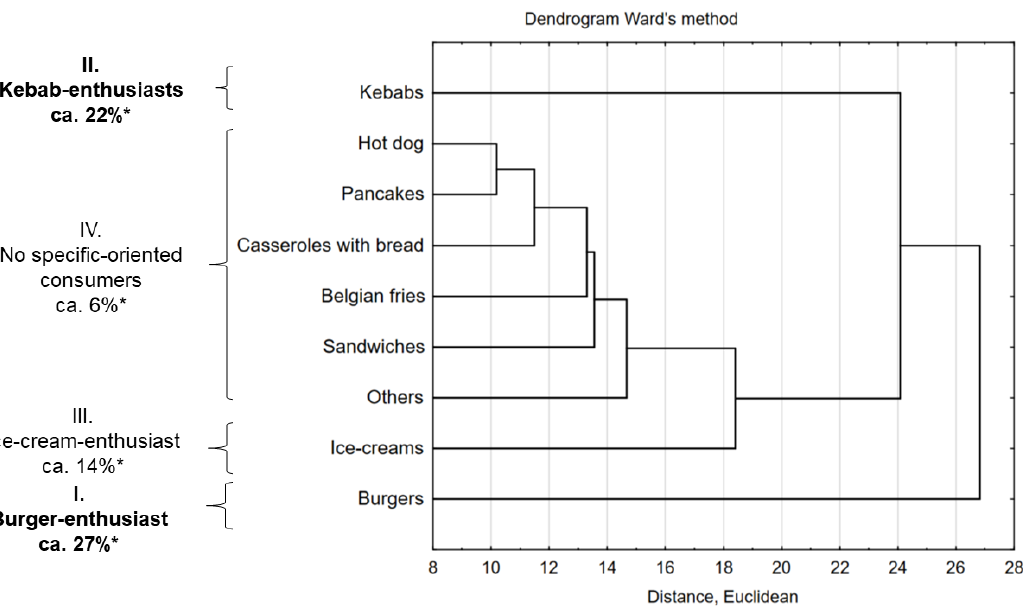
Figure 1. Consumers’ street food profile taking into consideration meals (* percentage of responses; others—Asian, Italian, Tex-Mex meals or just places with good food).